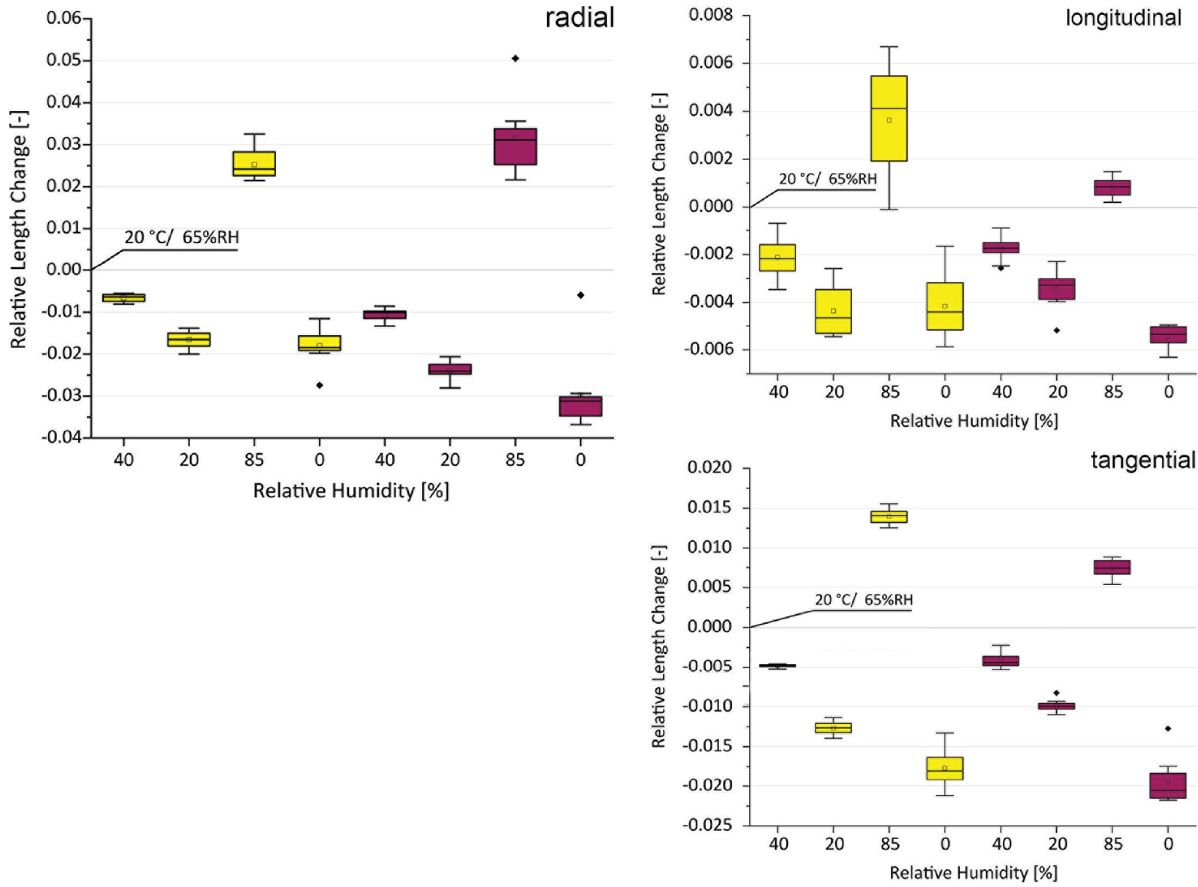
Fig 7. Swelling and shrinkage behavior of native oak (yellow) and native larch (purple) upon changing humidity levels. All levels show the thickness swelling compared to the original sample dimension at RH 65% [0].